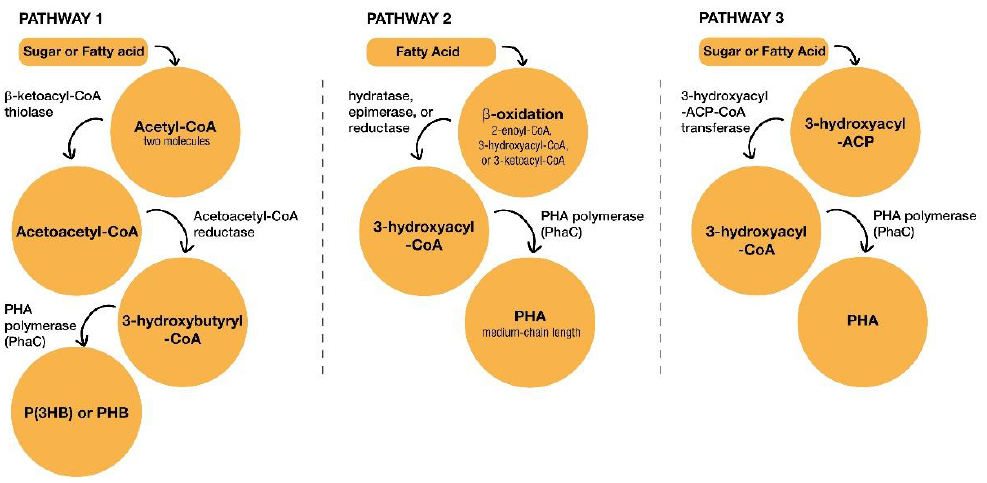
Figure 3. The three pathways leading to PHA synthesis.